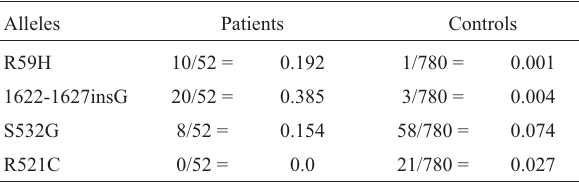
Table 1 - Allele frequencies in patients and controls. Alleles